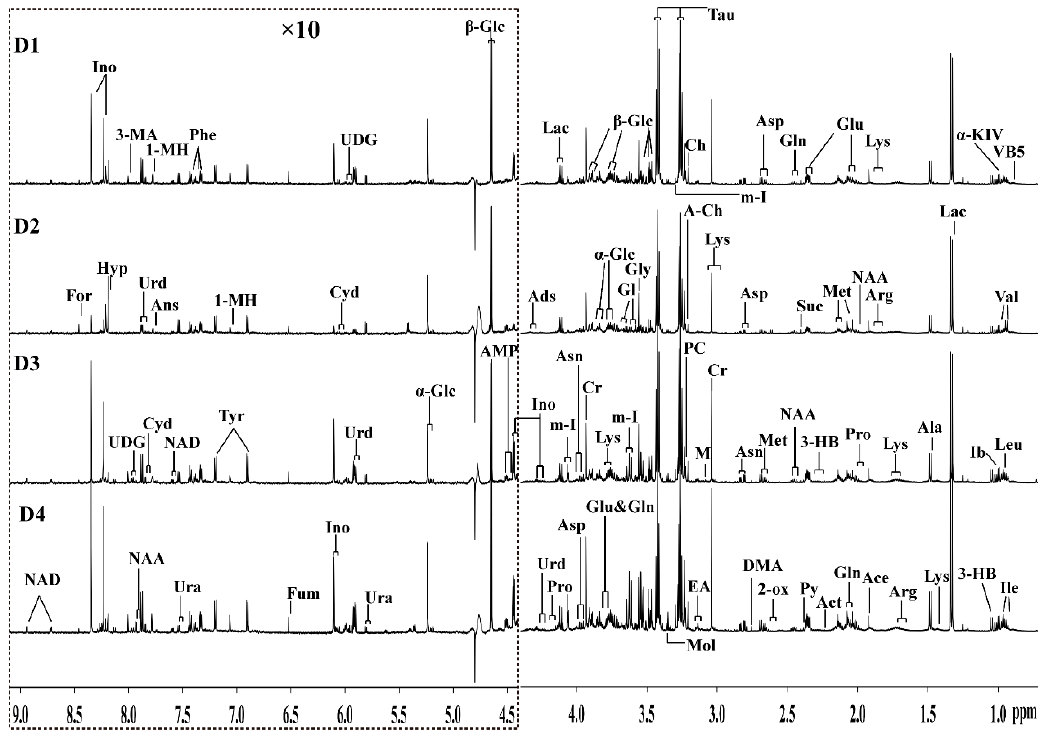
Figure 2. Representative 600 MHz water-suppressed 1 H-NMR spectra ( δ 0.5–9.2) of the intestine of grouper fed diets containing different taurine contents (D1: 0.0%, D2: 0.5%, D3: 1.0%, D4: 1.5%) at FD84. The region of δ 4.4–9.2 was vertically magnified 10 times compared with the region δ 0.5–4.4